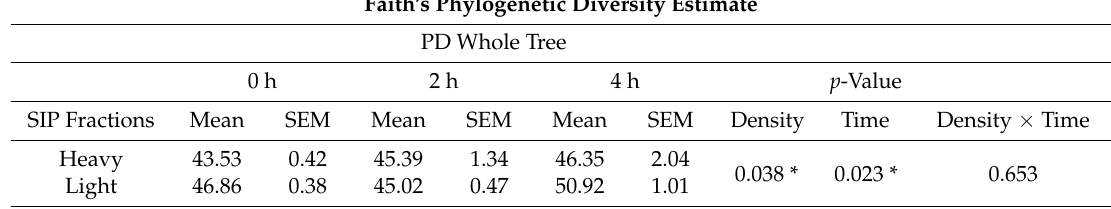
Table 1. Faith’s phylogenetic diversity estimate in ‘heavy’ and ‘light’ density gradient fractions before (0 h) or 2 h and 4 h after administration of [U 13 C]